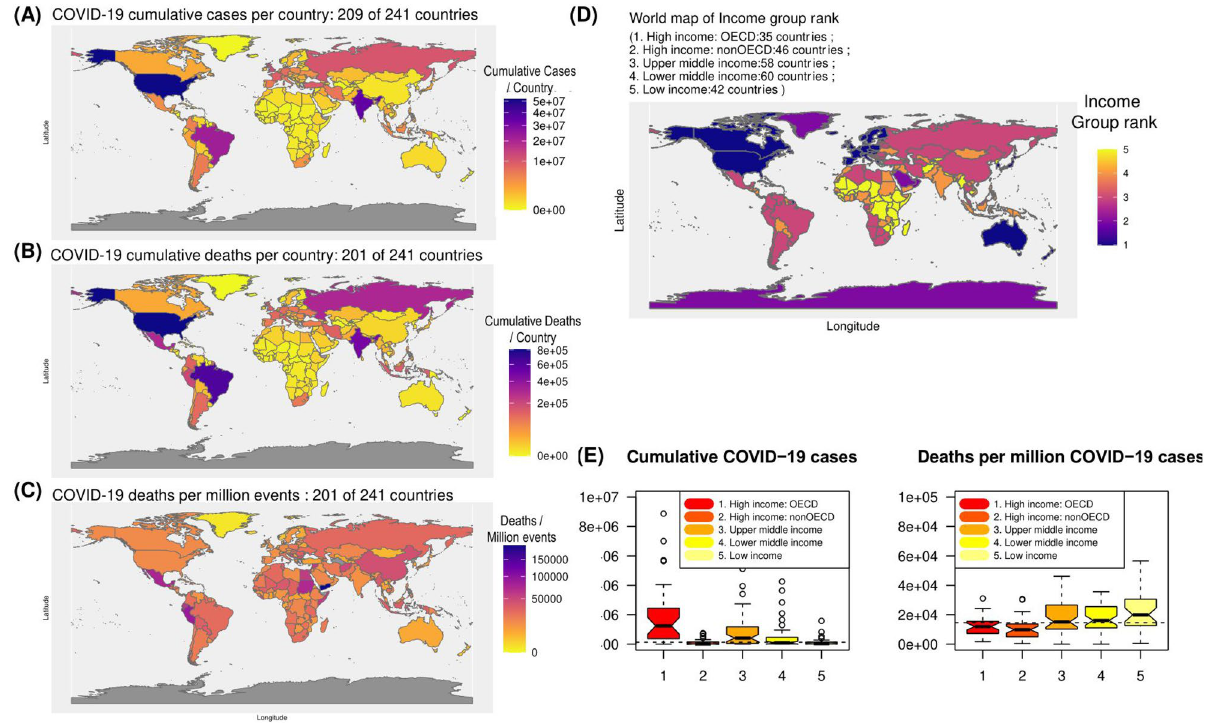
Figure 1. COVID-19 in world scenario in 2021. ( A ) Cumulative cases of COVID-19 per country, ( B ) cumulative COVID-19 associated deaths per country, ( C ) cumulative deaths per million events (COVID-19) per country and ( D ) income group rank of the country is plotted in world map. ( E ) Box plot of COVID- 19 cumulative cases or deaths with respect to income group ranking of the countries. The boundaries or geographical coordinates are used only for data representation. The administrative/geographical boundaries might differ. The spatial polygons or points for world map is obtained using R package (rnaturalearth) 11 Genome surveillance of SARS‑CoV‑2 in 2021 in India. To study the details and the possible VoCs of SARS-CoV-2 prevalent in India during the catastrophic second wave, we retrieved patient metadata and the associated genome sequences (n = 44514) from GISAID for the month of January (4 months prior second wave) to September, 2021 (4 months post second wave). The respective metadata file (Supplementary Table S3) of all VOCs and VoIs as described in the Methodology section were selected for the analysis. At least 38 SARS-CoV-2 VoCs/VoIs are found across India from January to September 2021 with minimum 100 recorded cases (Supple- mentary Table S4). The lineages (VoCs/VoIs) were ordered in descending manner based on incidences, and top ten different variants of the virus as identified in India till September 2021 are plotted (Fig. 2). Due to various sub-lineages of B.1.617.2 (Delta), AY.* (Delta-like), subseries was continuously renamed by Pango nomencla- tures in GISAID. AY.4 got reclassified as AY.4.2, AY.12, AY.22, AY.23, AY.103, AY.122, etc. Hence, a generalized term ’AY.x’ is being used for the newly classified AY.4 variant. The graph is constructed based on percentage of incidences of VoCs in the respective month. The top ten lineages found based on their prevalence (in %) per month are shown in Table 1 and Fig. 2.